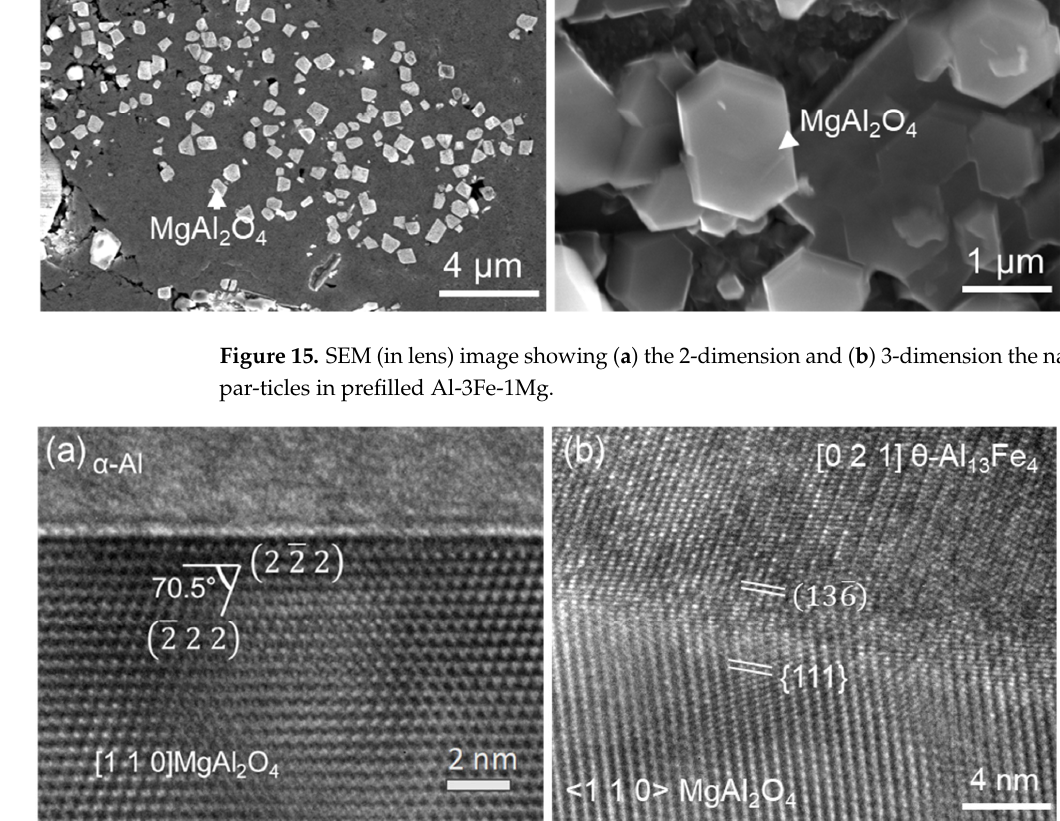
[1 1 0] MgAl 2 O 4 //3.4° [0 2 1] θ‐ Al 13 Fe 4 . [66]